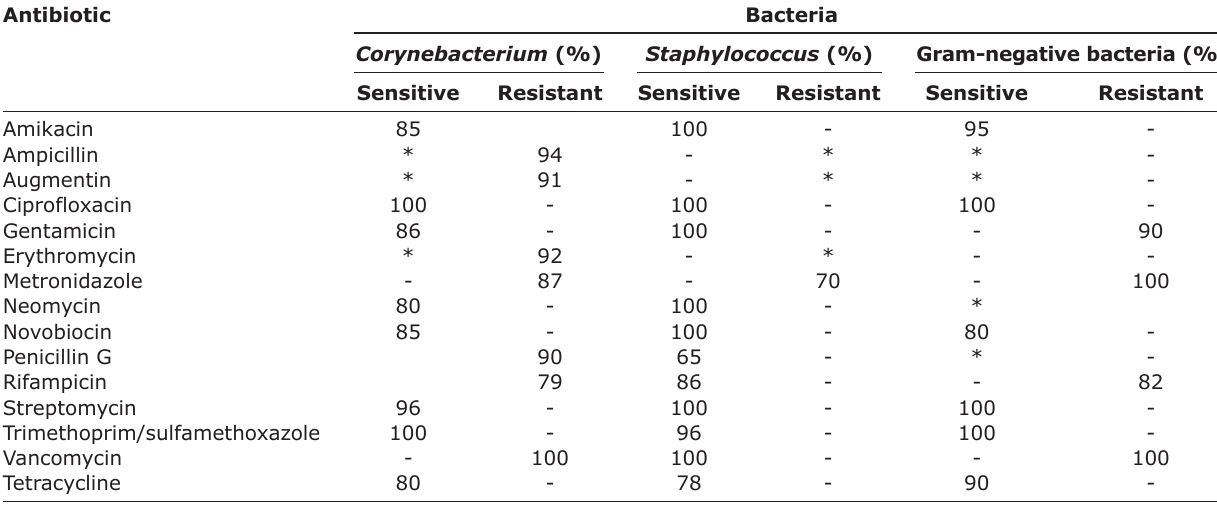
Table-1: Antibiogram of reference drugs against bacterial isolates from camel abscesses.